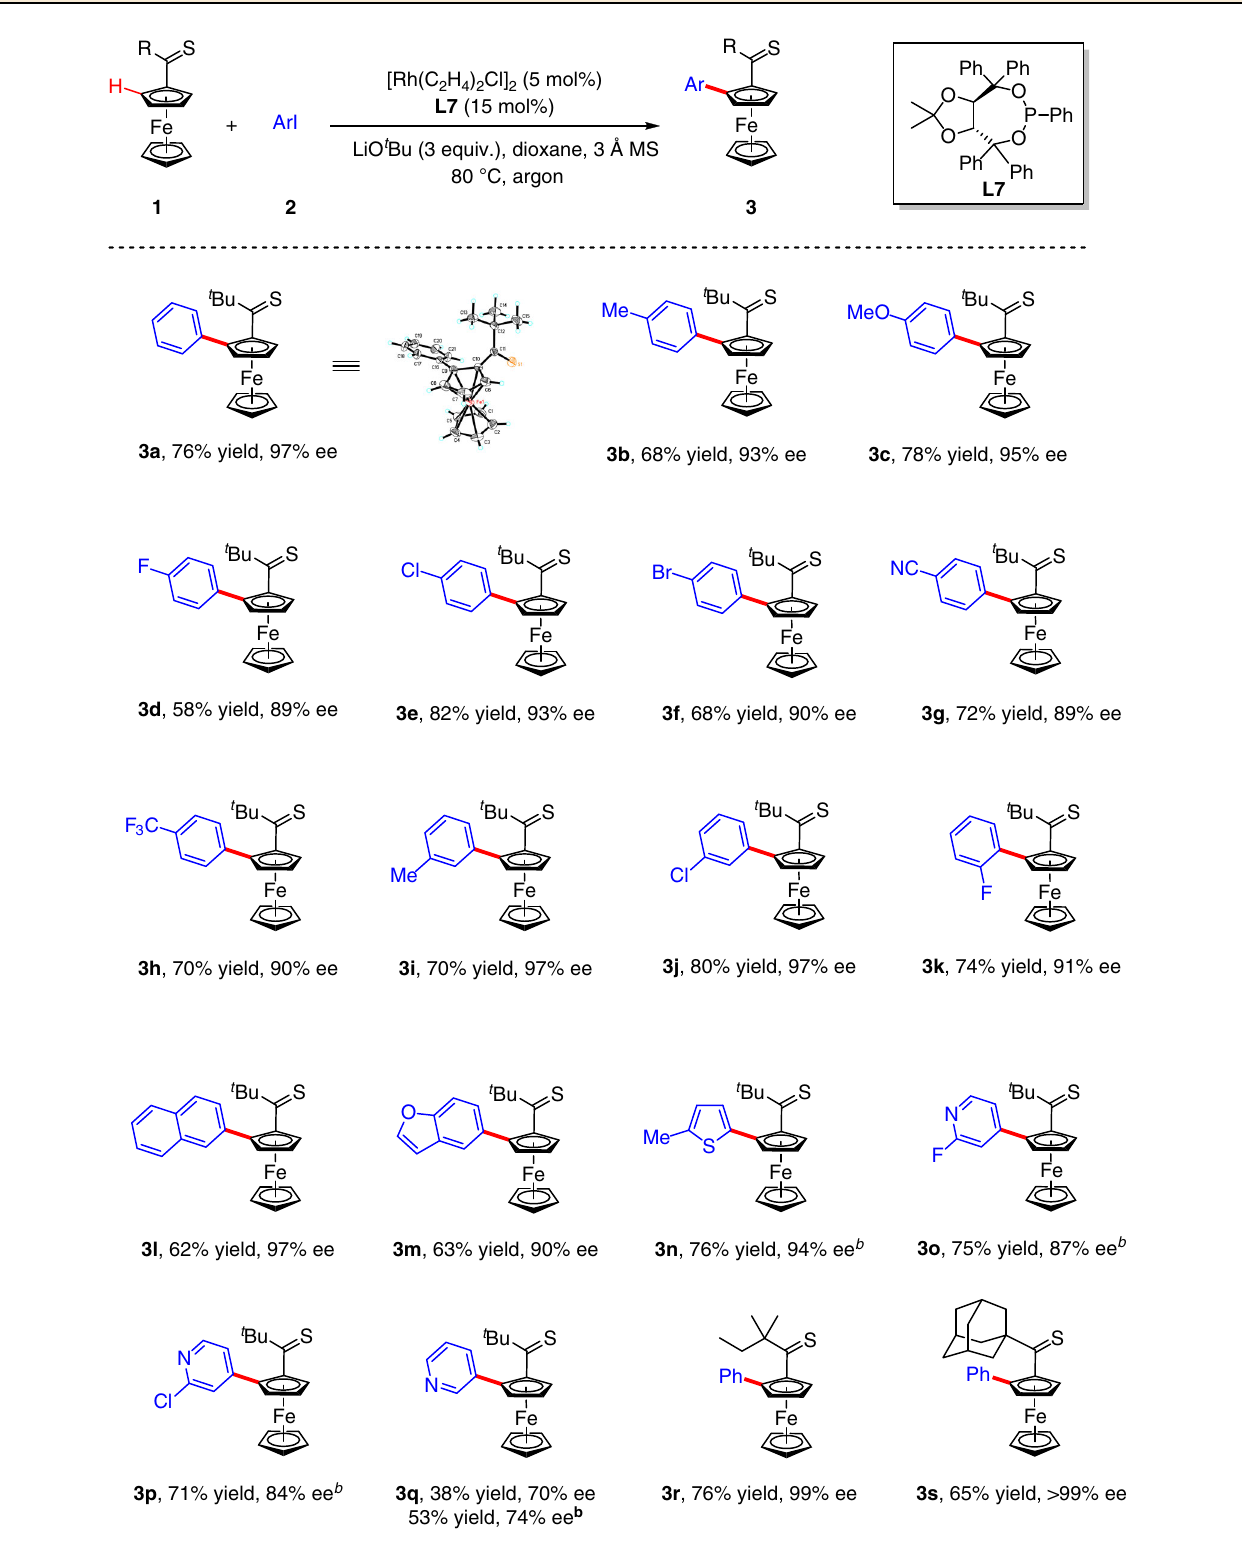
Table 2 Scope of asymmetric C – H arylation